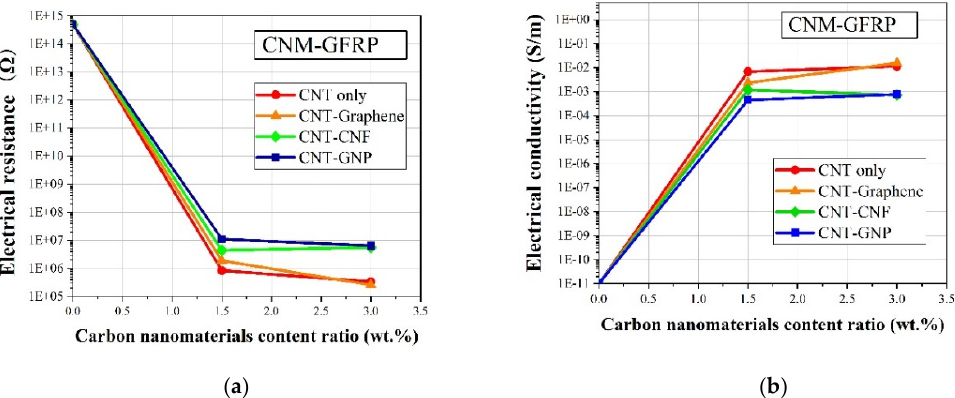
Figure 5. ( a ) The electrical resistance and ( b ) electrical conductivity of the CNM-incorporated GFRP composites. GFRP